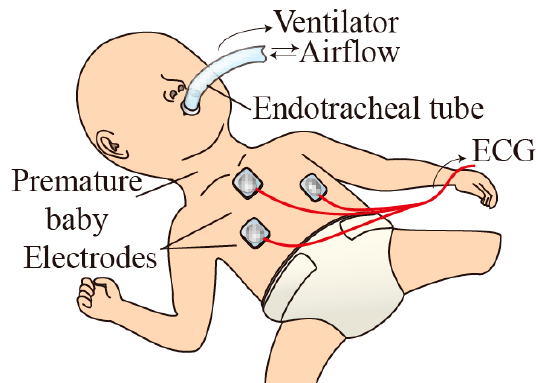
Figure 2. Breathing control and heartbeat detection in premature baby in